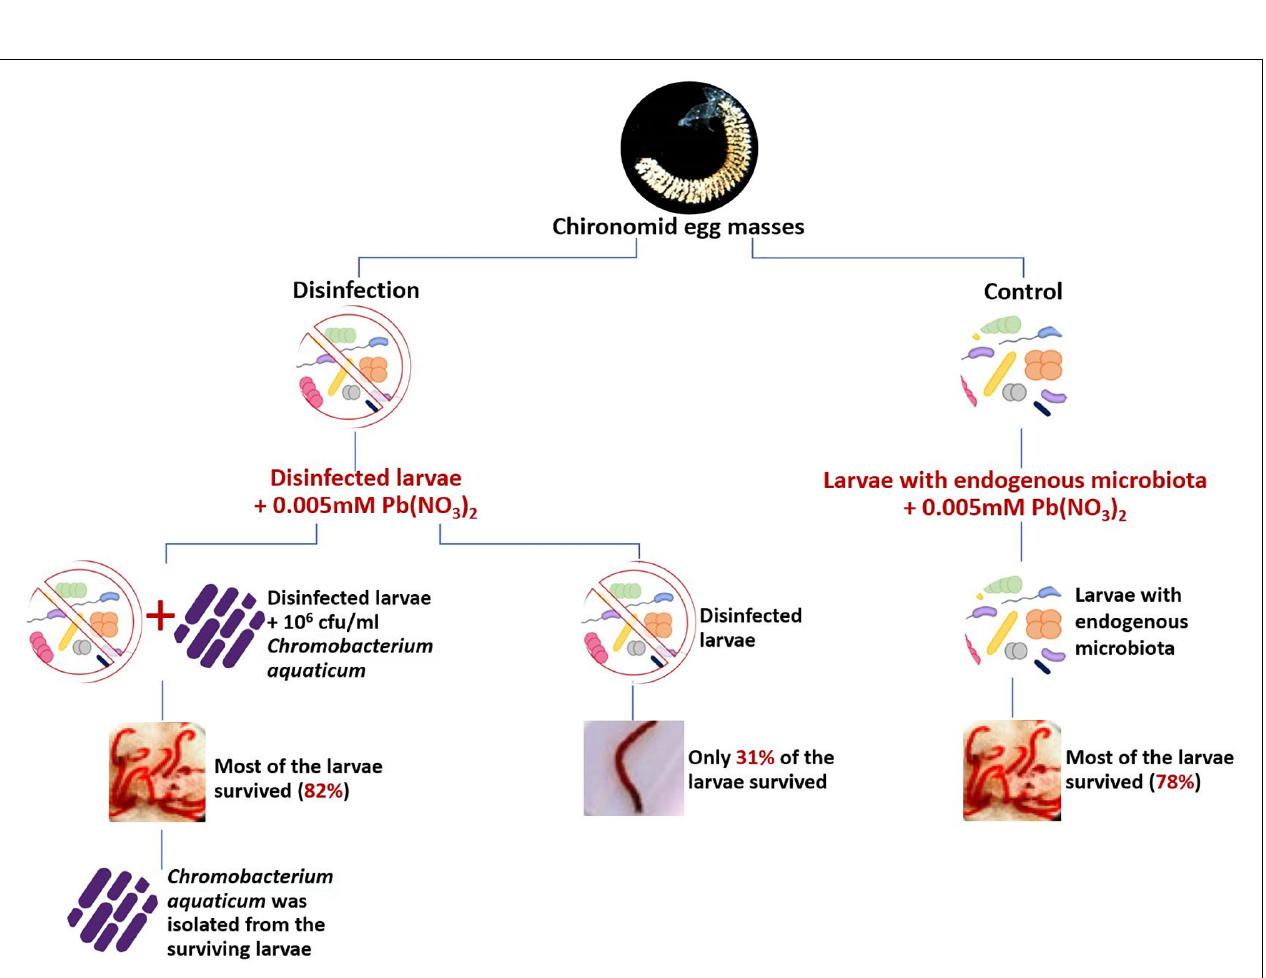
FIGURE 1 | Koch’s postulates were applied to demonstrate the role of the chironomid microbiome in protecting its host from toxic metals. Untreated larvae that contained the endogenous microbiota survived significantly better in lead-nitrate environments in comparison to disinfected (with chlorhexidine gluconate 0.05% and cetrimide 0.5%) larvae. The supplementation of Chromobacterium aquaticum that has been previously isolated from larvae that survived in the presence of lead, to the disinfected larvae in lead nitrate environment, significantly improved the survival rate of the disinfected larvae. The survival rate of untreated larvae that contained its normal microbiota was 78% (right side of the figure) while the survival rate of the disinfected larvae in the presence of lead was only 31% (Left side of the figure). The addition of C. aquaticum to the disinfected larvae that were incubated with lead caused the survival rate to rise from 31 to 82% (left side of the figure; data from Senderovich and Halpern,